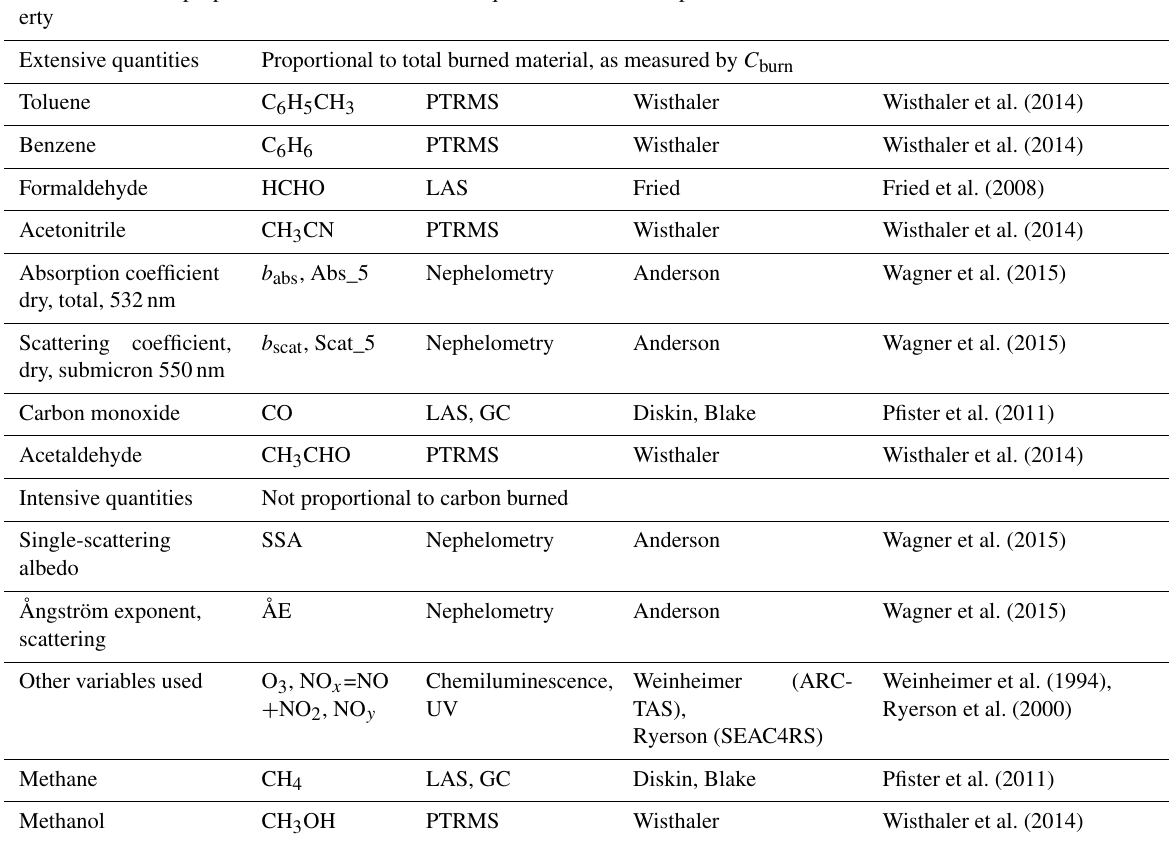
Table 1. Indicator variables. Concentration or